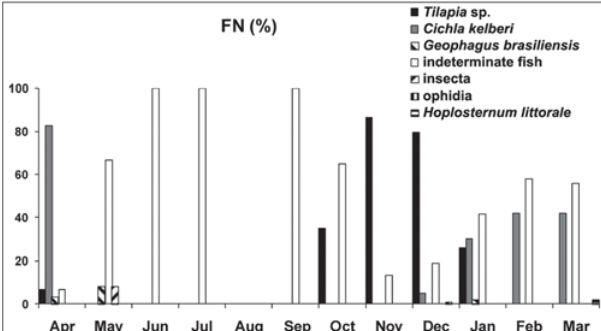
Fig. 2. Means and standard deviations of the Repletion Indices (RI) of Cichla kelberi during the collection period.